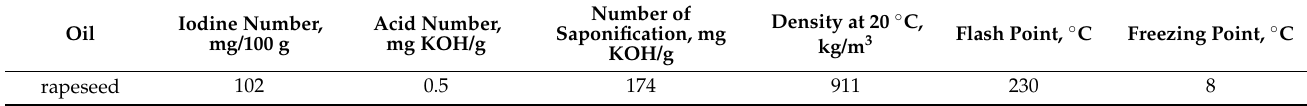
Table 3. Physico-chemical parameters of rapeseed